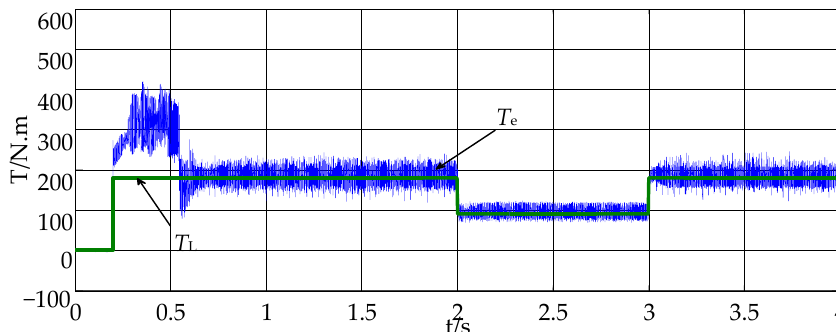
Figure 11. Load and torque waveform.